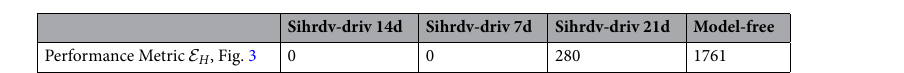
Table 1. The value of the Performance Metric E H for the retrospective analysis.